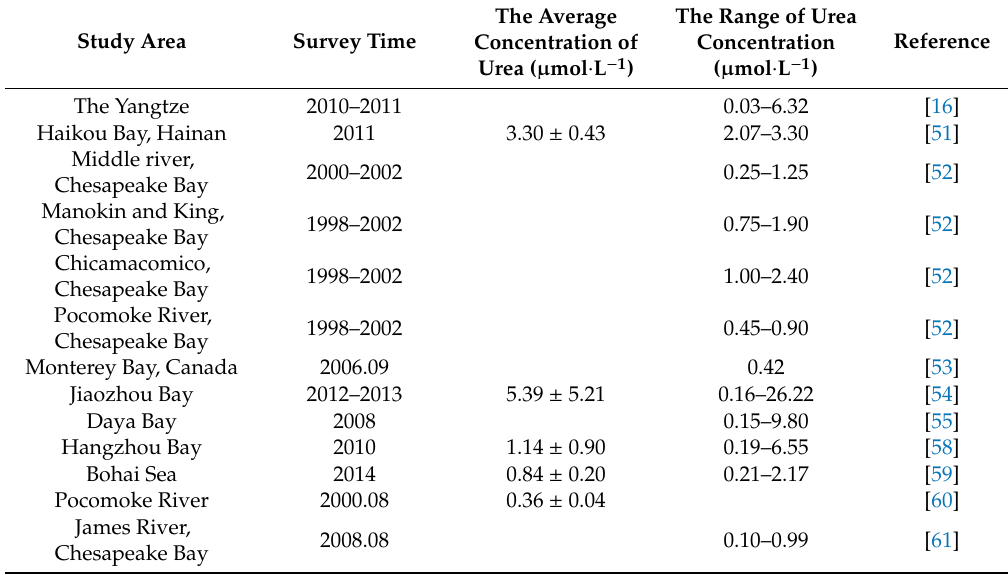
Table 3. Comparison of urea concentration in the ZJB with other bays and